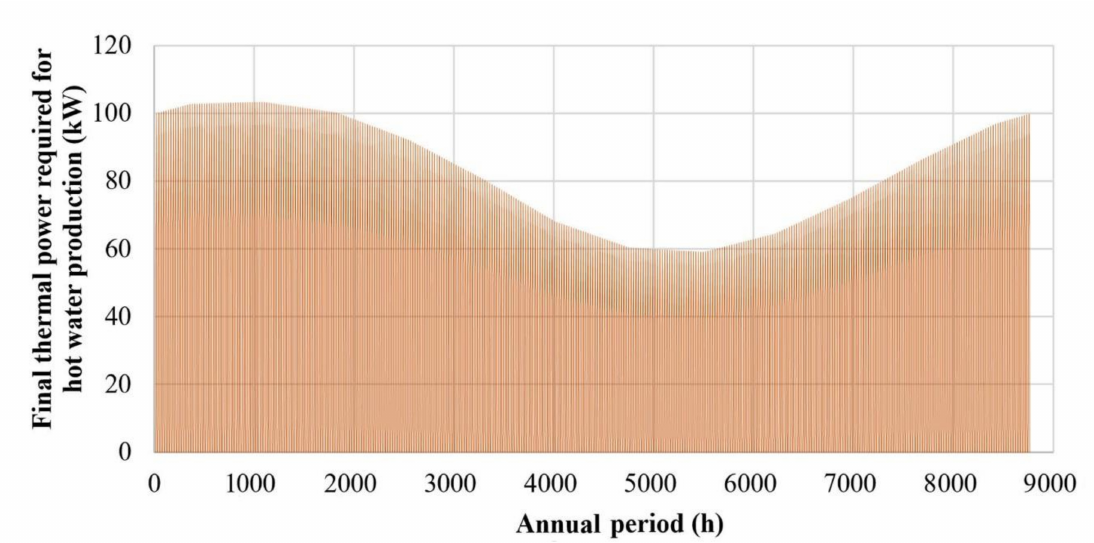
Figure 3. Thermal power consumption annual time series for hot water